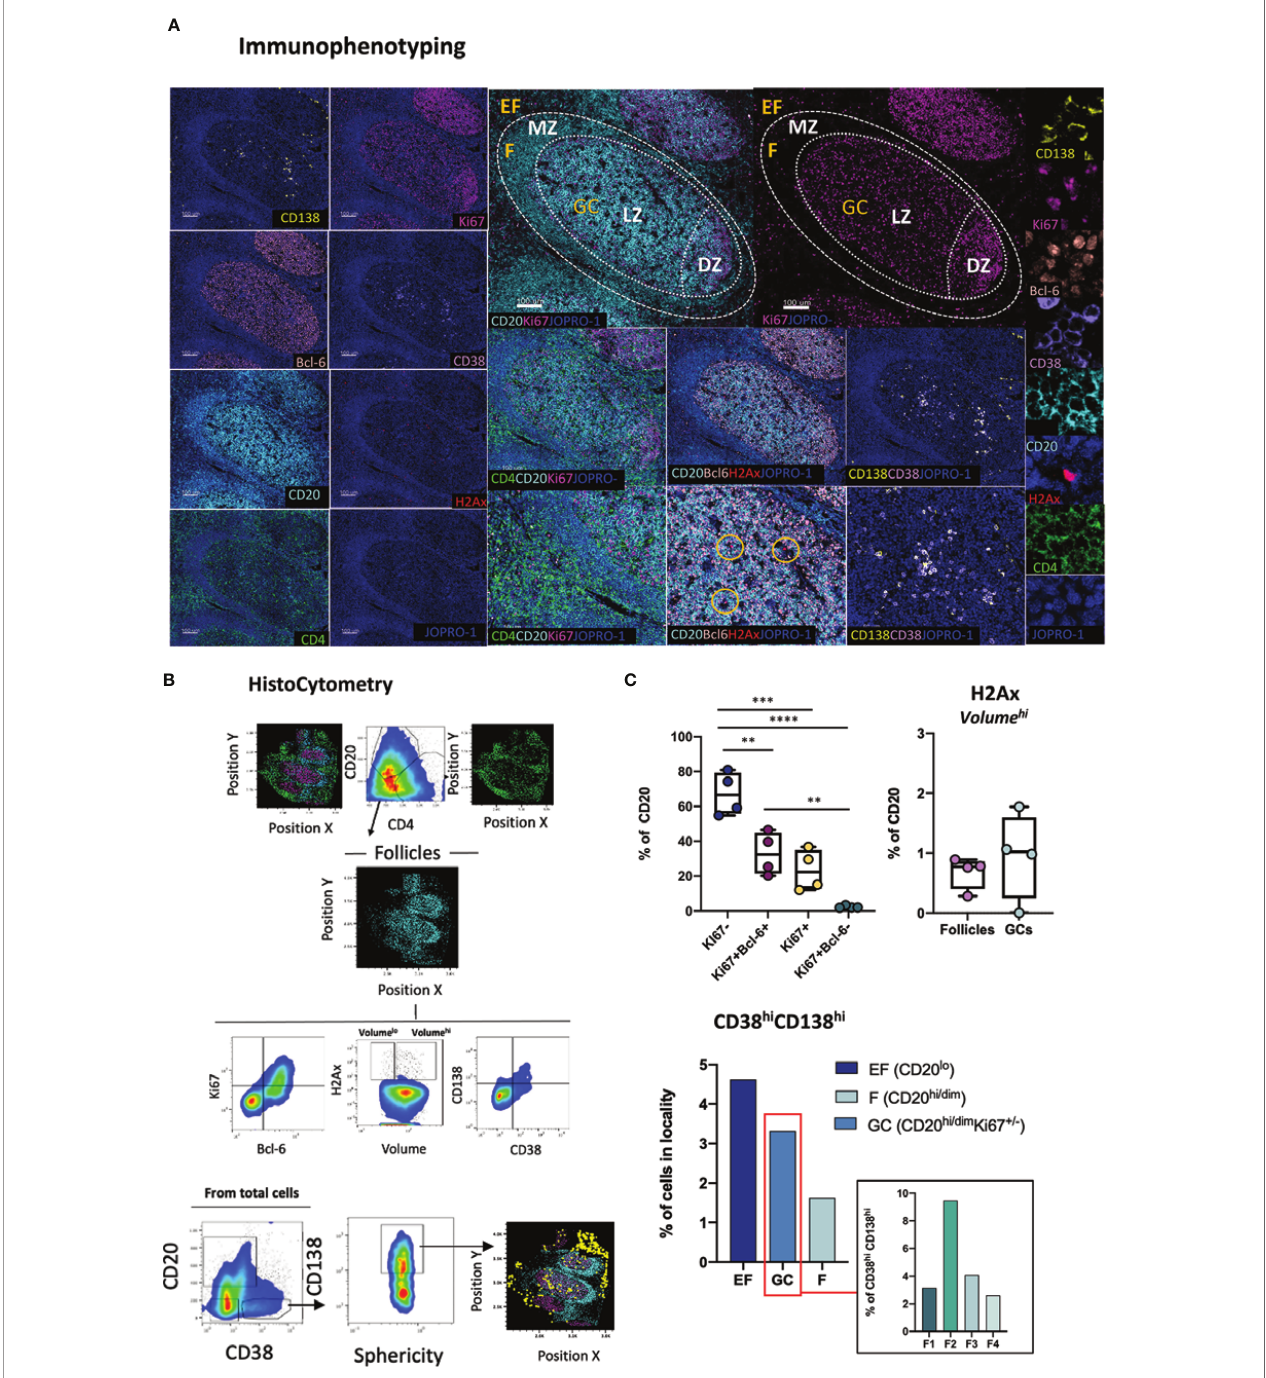
FIGURE 3 | Development of a multispectral panel for the topological examination of B cells. (A) Representative example of antibody staining patterns for CD138 (yellow), Ki67(magenta), Bcl-6 (orange), CD38 (violet), CD20 (cyan), H2Ax (red), CD4 (green) and nuclar staining (JOPRO-1, blue) and distribution of each marker with respect to the MZ, LZ and DZ (middle panels). Orange circles in the lower row images denote H2Ax events. (B) Gating strategy used for the immunophenotyping of various B cell populations and CD38hiCD138hi cells in GC (CD20 dim Ki67 hi ), F (CD20 hii/dim ) and EF (CD20 lo ) areas. (C) Box plots showing the frequencies of various B cell populations (as de fi ned by the expression of Ki67 and Bcl-6), H2Ax Volume hi CD20+ cells and CD38 hi CD138 hi cells in a representative tonsil tissue section. Each circle represents a distinct follicle and each color denotes a distinct subpopulation. p values were derived from ANOVA analysis (Tukey ’ s multiple comparisons test). Images were acquired at 40x (NA 1.3) with 1% magni fi cation. Scale bars are 100um for all panels displaying an entire follicle), 50um for the middle panel close ups and 5um for the right panel single staining close ups. **p < 0.01, ***p < 0.001, ****p <